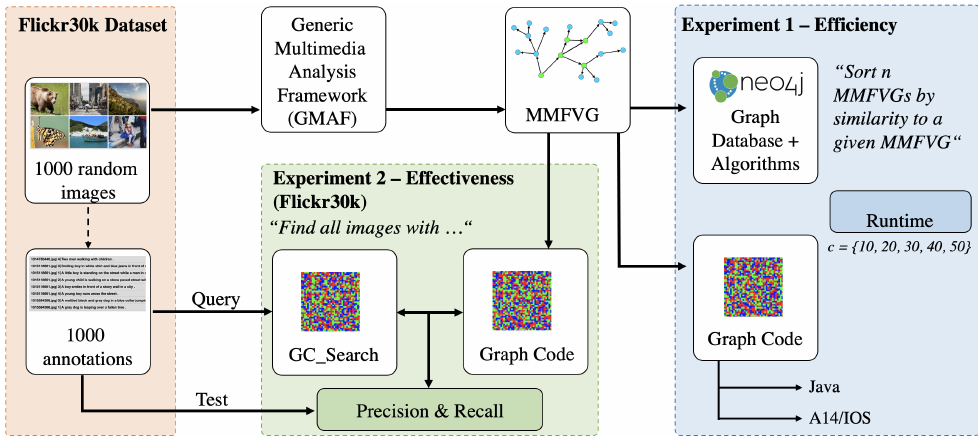
Figure 16. Design of experiments 1 and